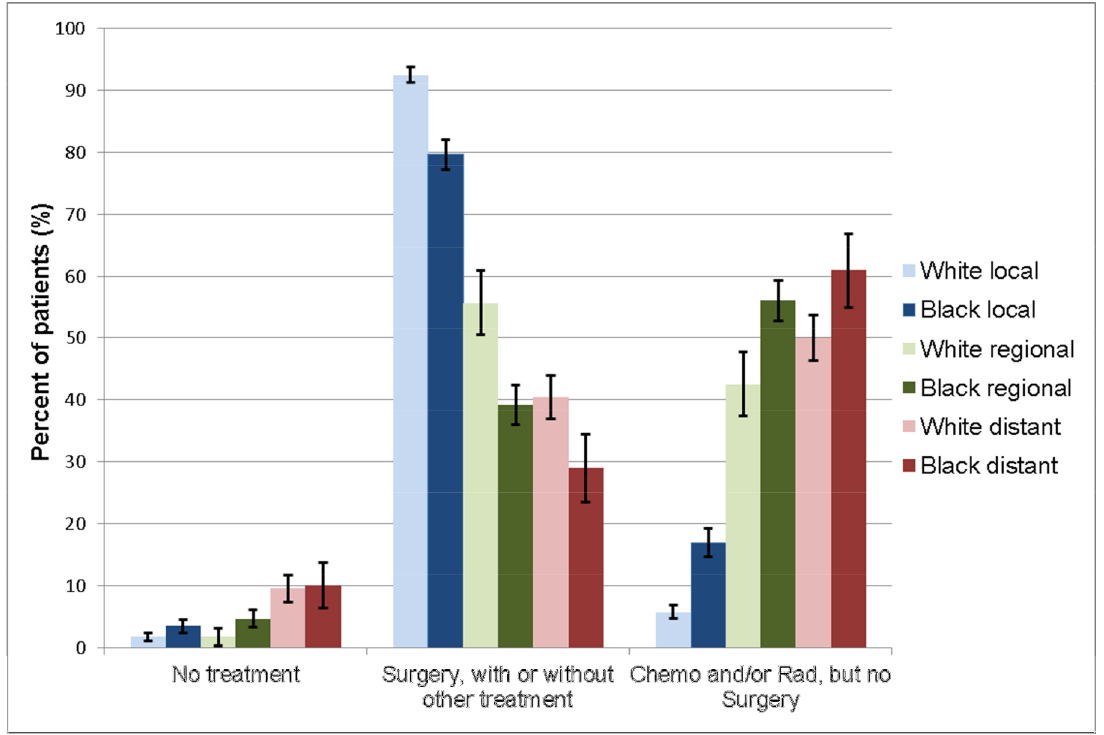
Figure 3. Differences in treatments received were still observed when stratified by extent of disease at presentation. Chemo: chemotherapy. Rad: radiation. Error bars represent standard errors of sample proportions.